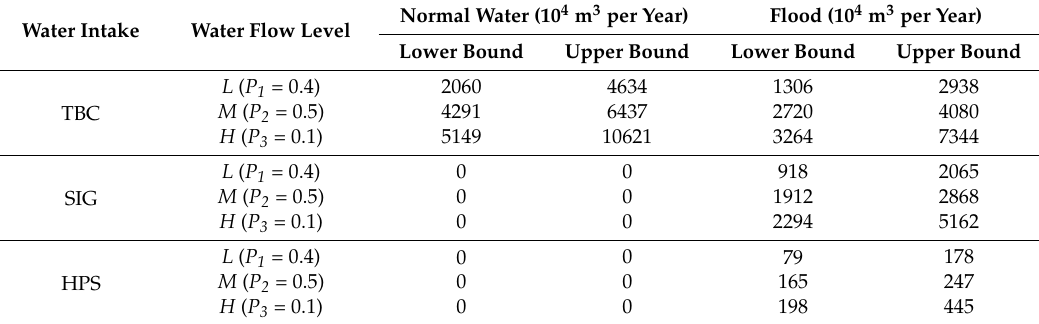
Figure 2. Frequency distribution of available water resources in the Nenjiang River Basin. Table 2. Water intake of each water intake at different flow levels in Nenjiang River.